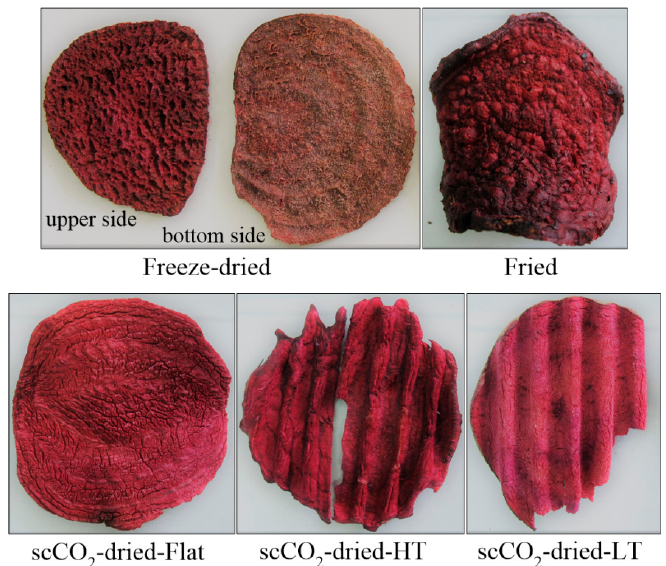
Figure 1. Images of the dried beetroot samples used in this study. Supercritical CO 2 -dried-HT sample was cooked in boiling water before drying, the rest were subjected to the drying processes in a raw state. The upper and bottom sides of a beetroot chip substantially differed from each other in appearance only in the case of freeze-dried samples.